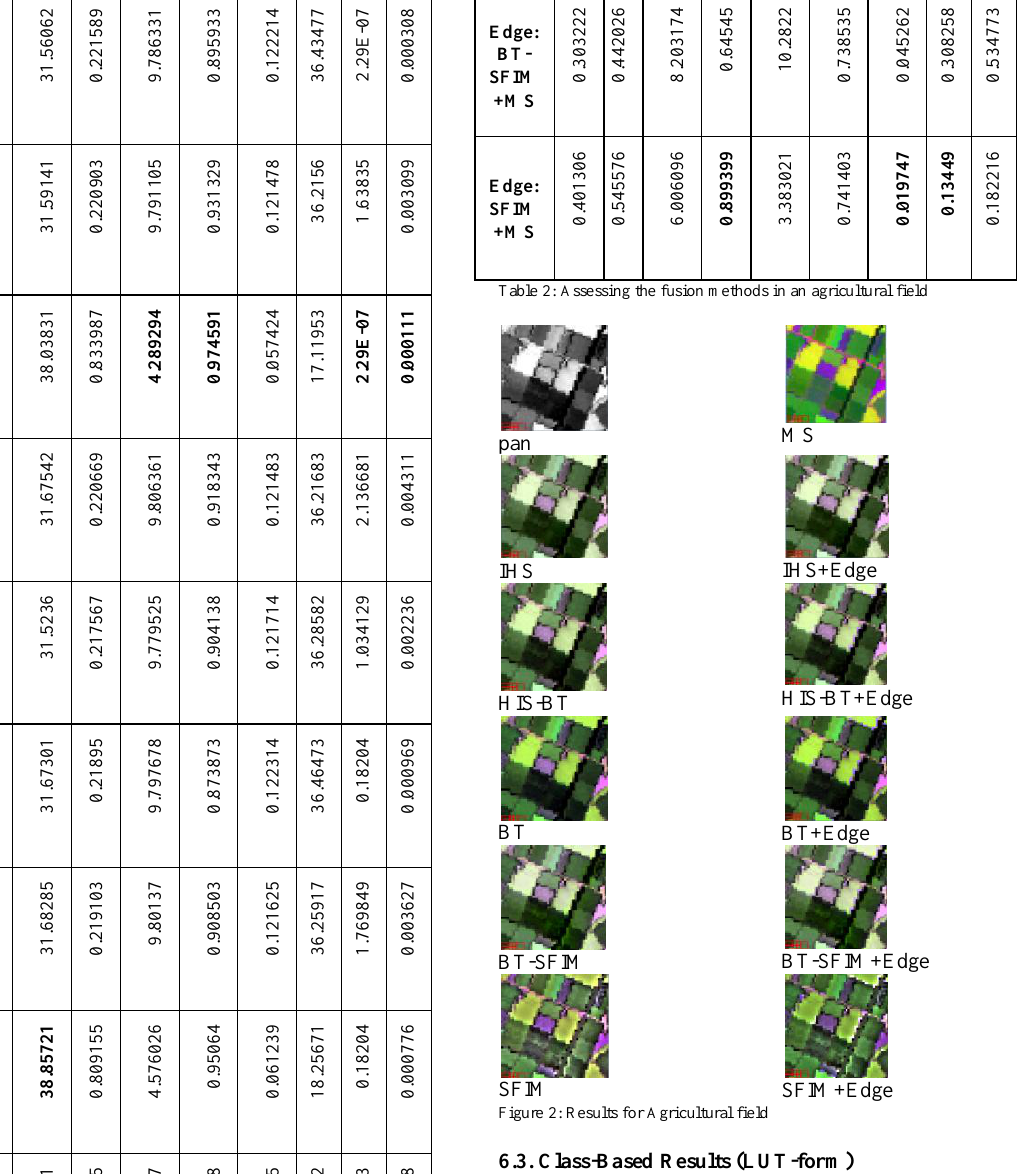
Table 2: Assessing the fusion methods in an agricultural field